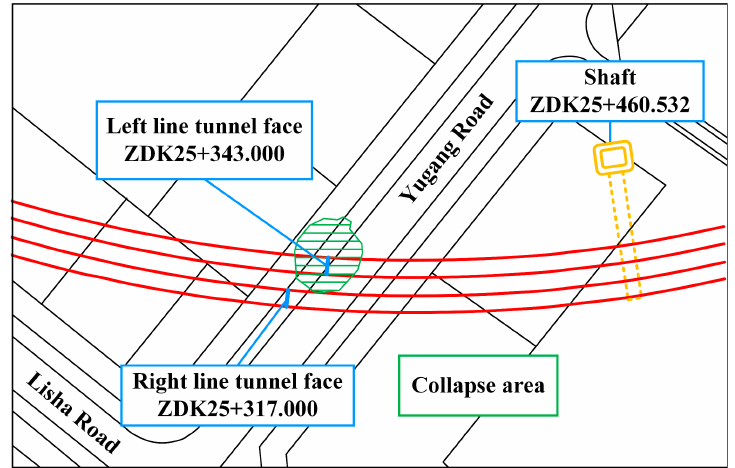
Figure 4. Location of the disaster.